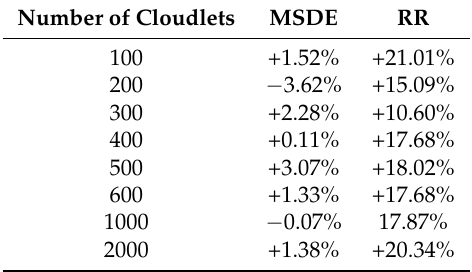
Table 12. Improvements of the MBO-ABC over MSDE and RR in simulations with an HPC2N data